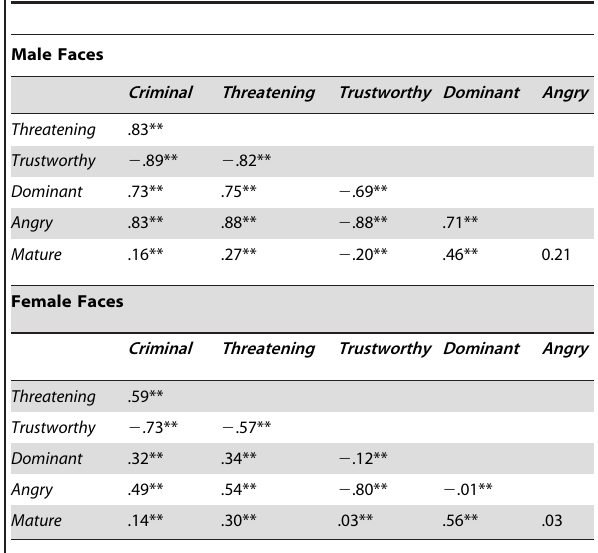
Table 2. Pearson’s Bivariate Correlation Coefficients for Male and Female Faces, Naturalistic